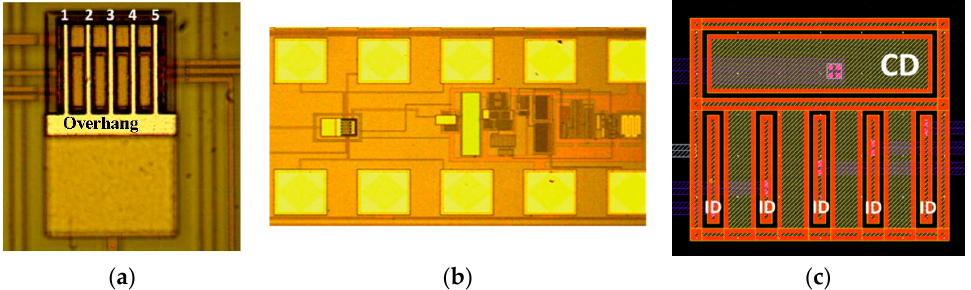
Figure 1. ( a ) Optical image of the five released cantilevers (26 μ m long, 1.45 μ m wide, 0.925 μ m thick) in which the overhang can be seen (6 μ m wide, 0.925 μ m thick). The five cantilevers are numbered to reference them in the main text; ( b ) Optical image of the whole system, including the cantilever array and CMOS transimpedance amplifier; ( c ) Image of the layout of the drivers with the individual drivers (ID) and common driver (CD) and their access. CD common driver is below the tip of the cantilevers and the ID individual drivers are between the middle and near-to-anchor part of the cantilevers.